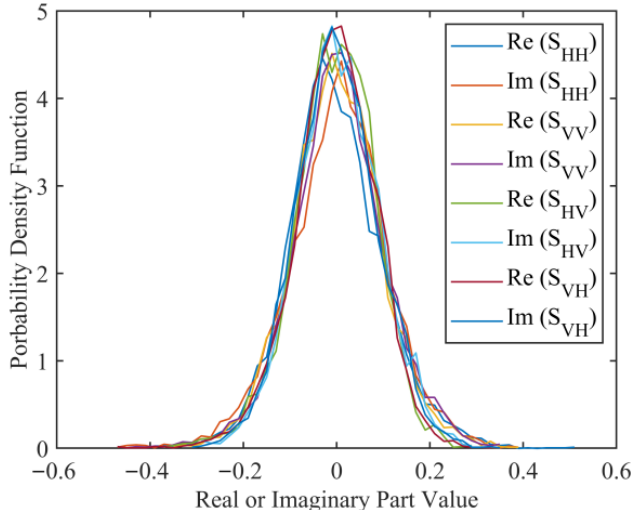
Figure 7. Measured PDFs of real and imaginary part values of the scattering matrix for rice field Scene 2 in LAMP at the Ku band and an incidence angle of 40°.